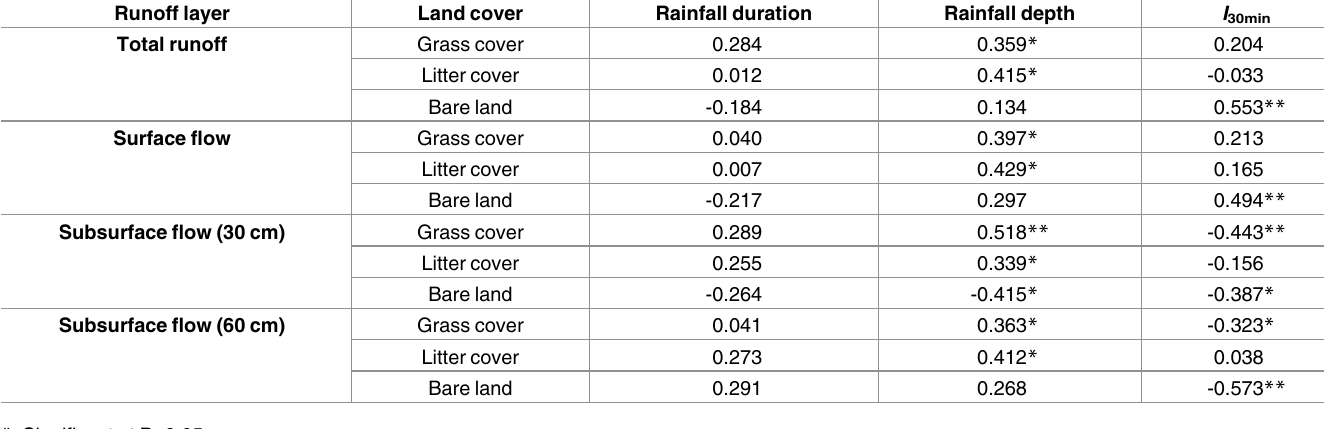
Table 3. Pearson correlations for runoff values and rainfall characteristics.